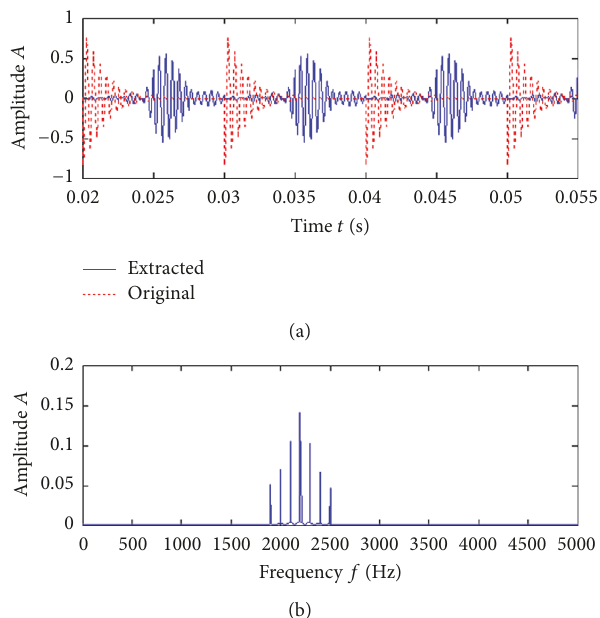
Figure 6: Bearing fault signal extraction result of FIR: (a) time domain waveform and (b) FFT spectrum.